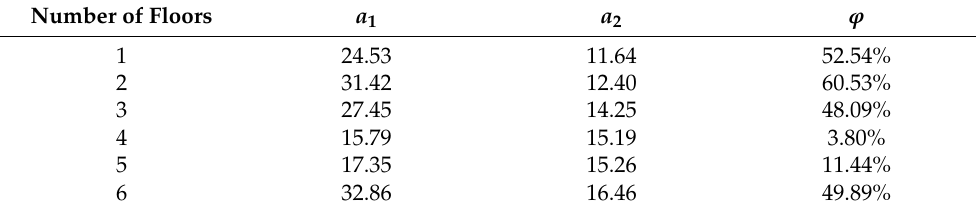
Table 6. Acceleration peak and vibration isolation ratio of the